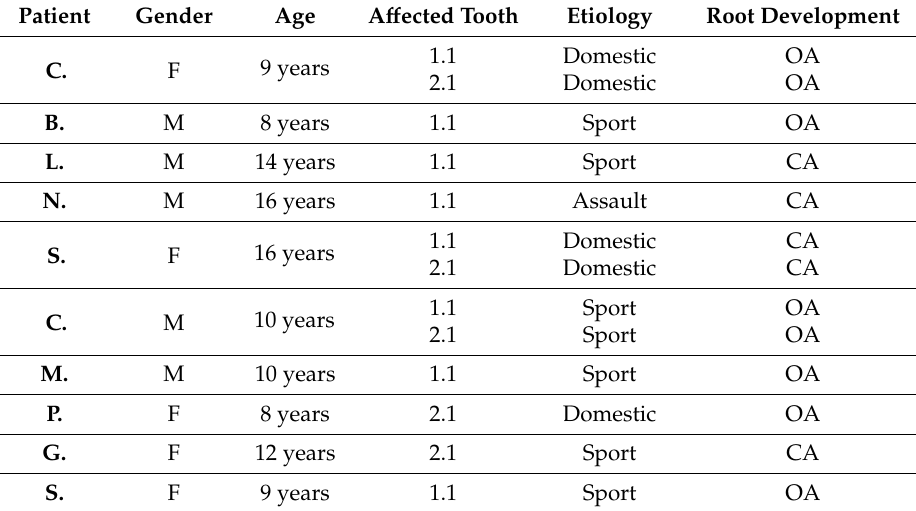
Table 2. The table shows epidemiological and etiological data of the sample.